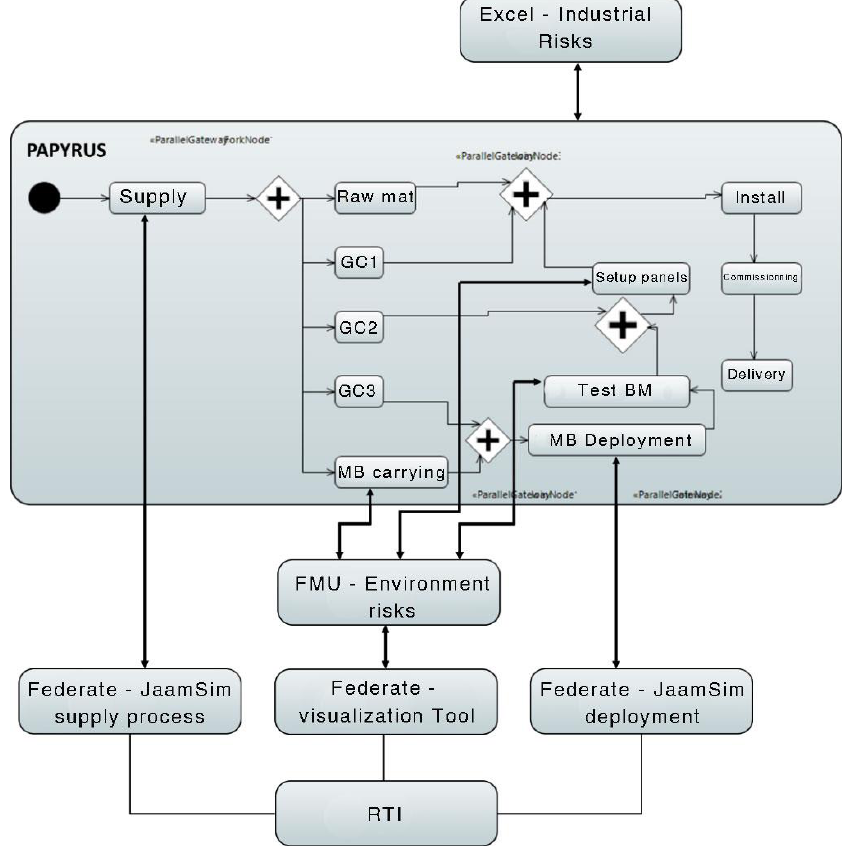
Figure 11. Papyrus orchestration process.